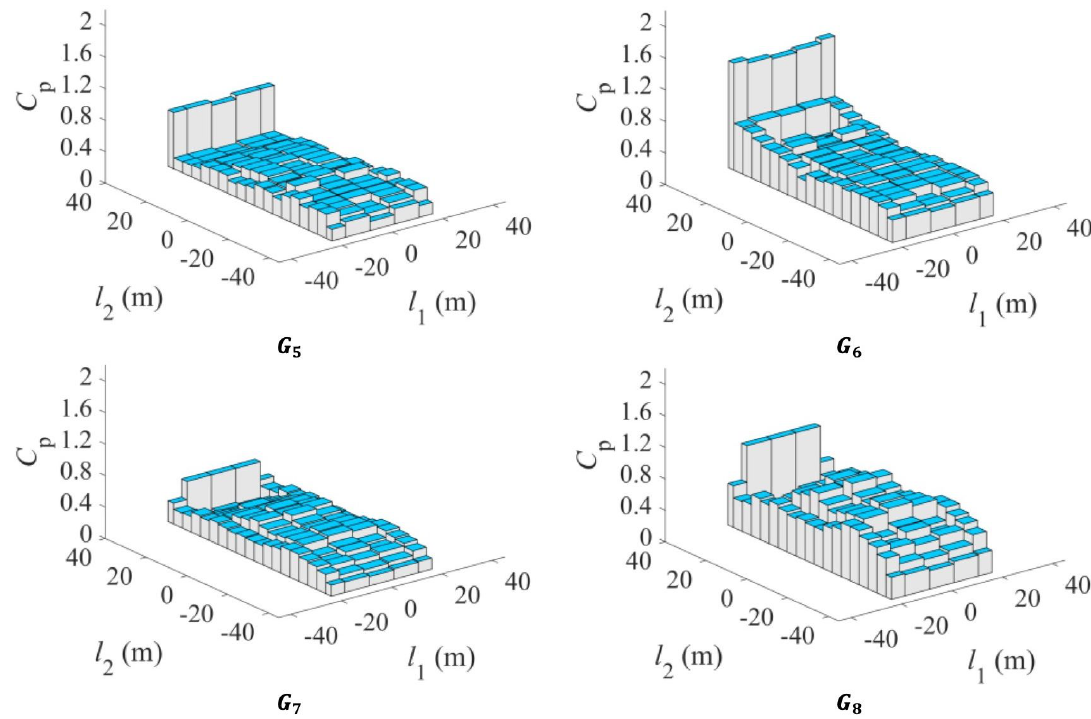
Figure 5: Mean pressure coeflcients of rectangular plan geometries with θ = 0 ∘